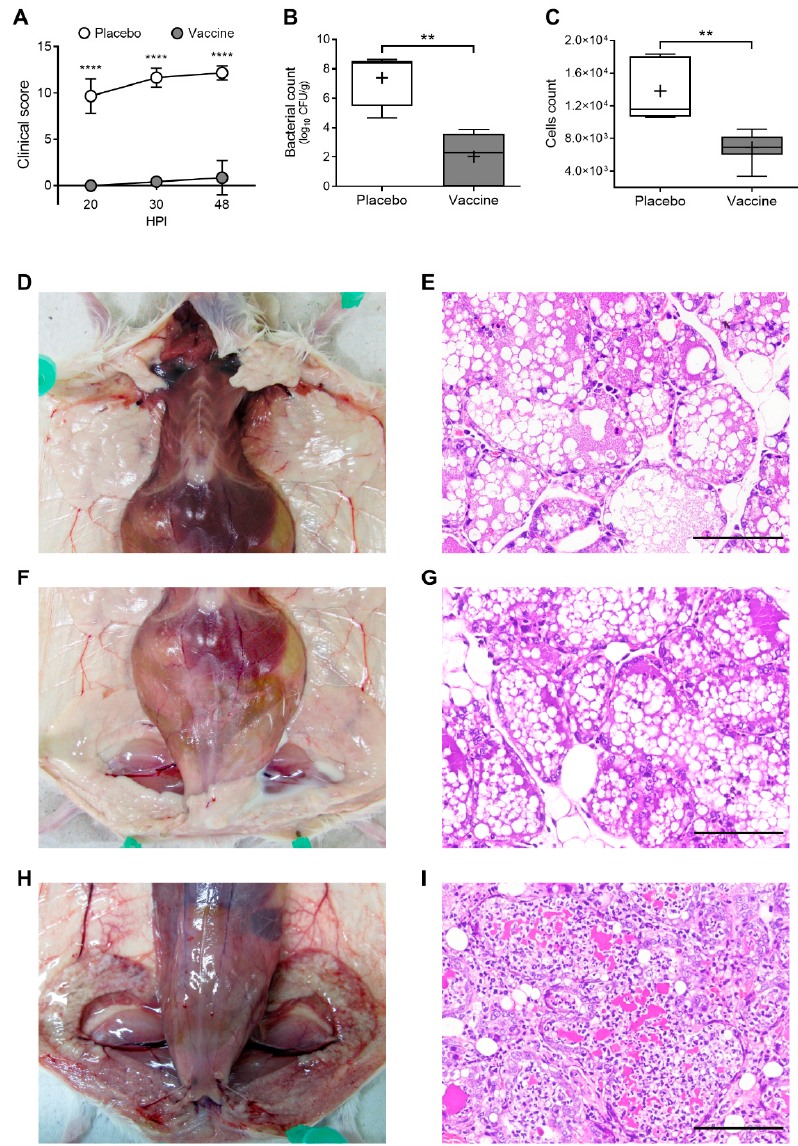
Figure 5. Proteoliposome-based vaccine decreases clinical symptoms, bacterial load and tissue damage after intramammary E. coli challenge. ( A ) Clinical score of vaccinated and placebo mice 20, 30 and 48 h after intramammary bacterial challenge (each circle represents the mean ± SD, n = 8). ( B ) Mammary tissue bacterial load of vaccinated and placebo mice, (log 10 CFU/g). ( C ) Quantification of the total number of cells within mammary glands histopathological sections of vaccinated and placebo mice. Horizontal lines within each box indicate the group median, while the crosses indicate the arithmetic mean (n = 8), ** = p < 0.01; **** = p < 0.0001. ( D , F , H ) Macroscopic evaluation of mammary tissue in vaccinated mice ( D , F ) and placebo ( H ) at day 35. In vaccinated mice, no evident mammary lesions were observed in glands inoculated with PBS ( D ) and in most of the glands challenged with E. coli ( F ). The placebo group shows tissue damage: mammary parenchymal enlargement, edema, congestion, friability, and consolidation ( H ). ( E , G , I ) Microscopic evaluation of mammary parenchyma in vaccinated mice ( E , G ) and placebo ( I ) at day 35. No obvious microscopic changes are observed in the glands inoculated with PBS ( I ) and challenged with E. coli in the vaccinated group ( G ); challenged glands from the placebo group show loss of glandular architecture, degraded mammary epithelium, and alveoli filled with massive immune cell infiltration ( I ). Images correspond to representative mice from each experimental group. Stain: hematoxylin and eosin. Bar = 100 µ